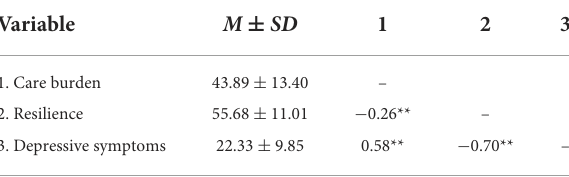
TABLE 2 Means, standard deviations, and correlations among